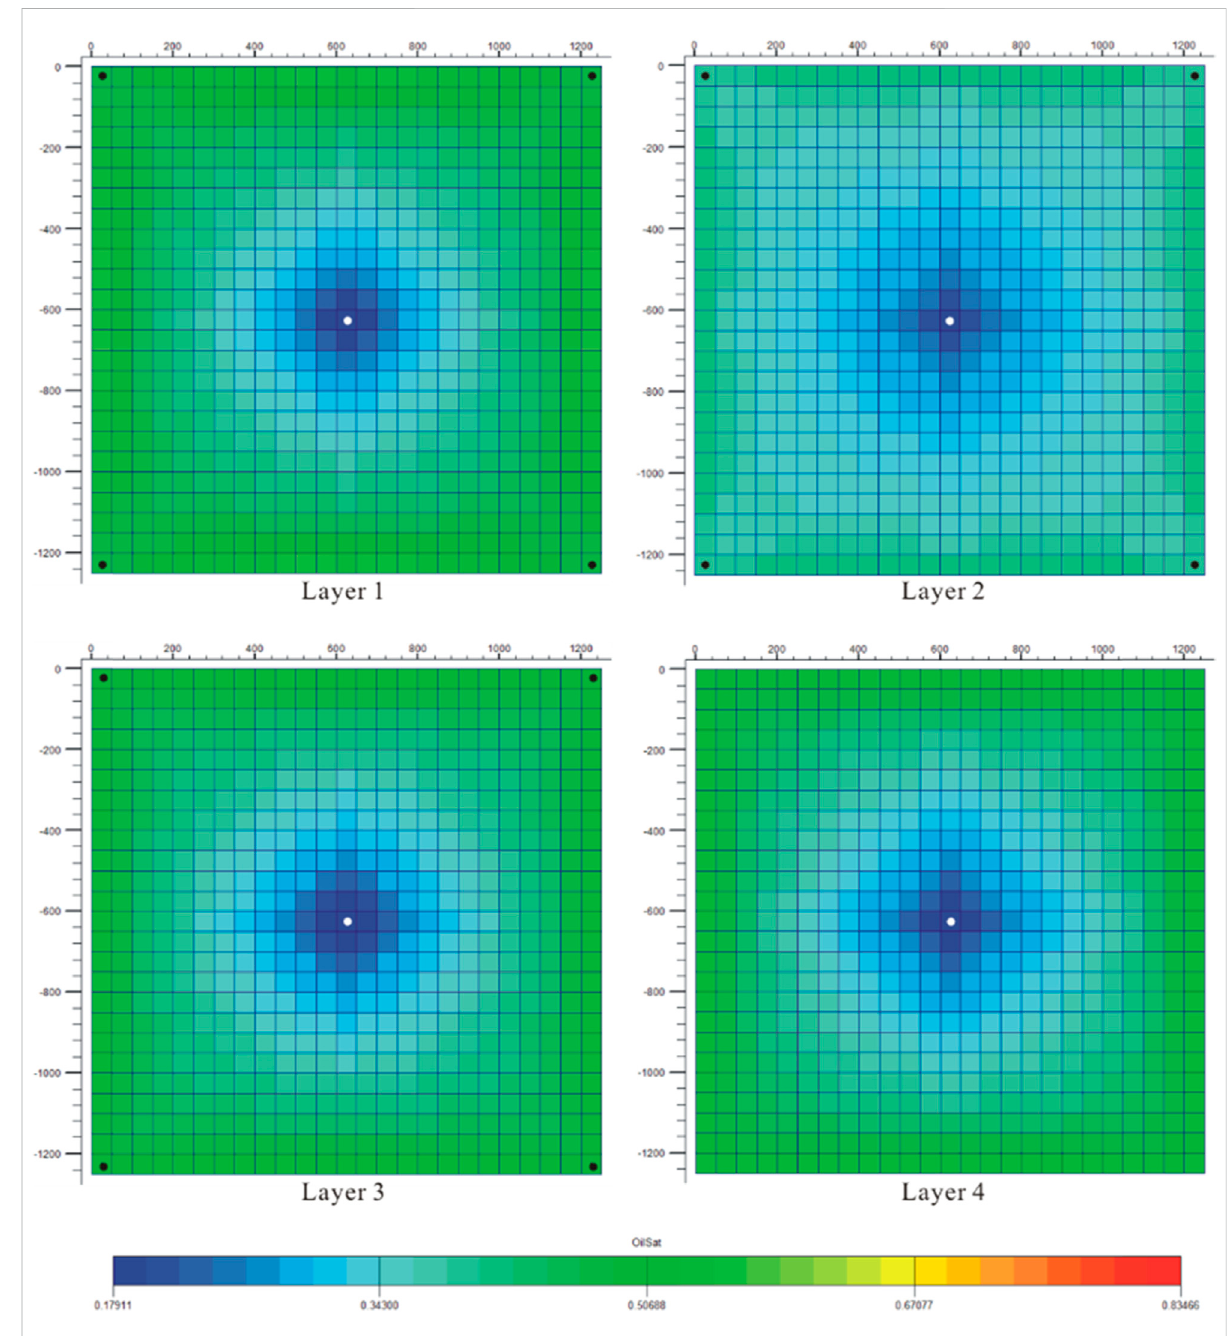
FIGURE 5 Optimized well location and the corresponding fi nal oil saturation pro fi les for the synthetic